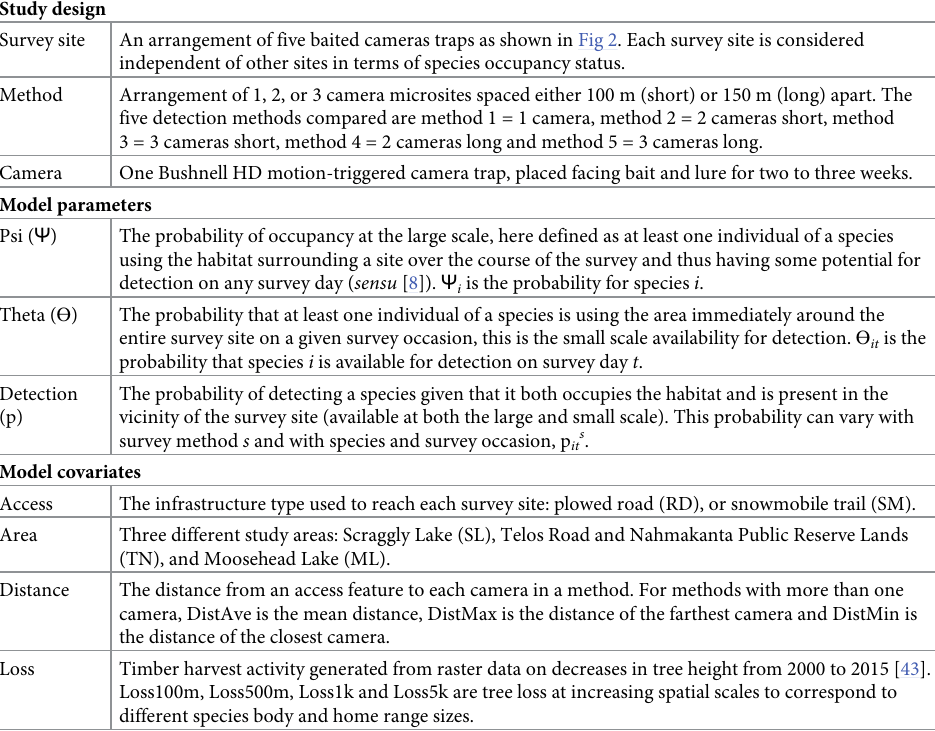
Table 1. Definitions of terms used in study design and modeling to assess the influence of different numbers and spacing of camera traps on the detection of mammals in Maine, USA. Study